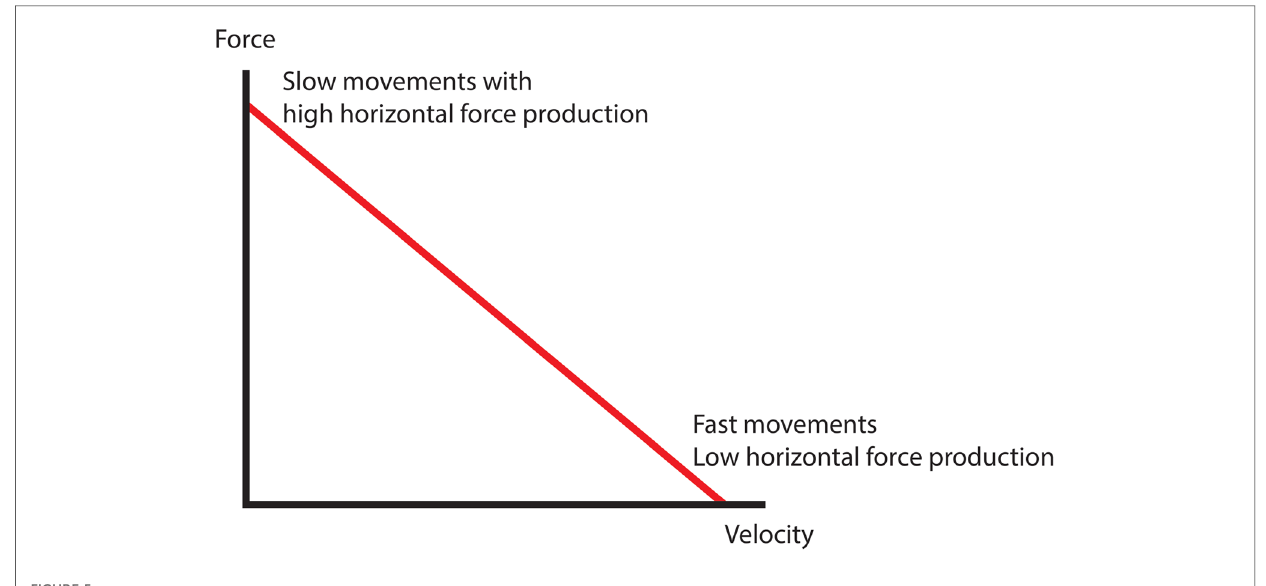
FIGURE 5 Proposed relationships between on- fi eld demands and force-velocity pro fi